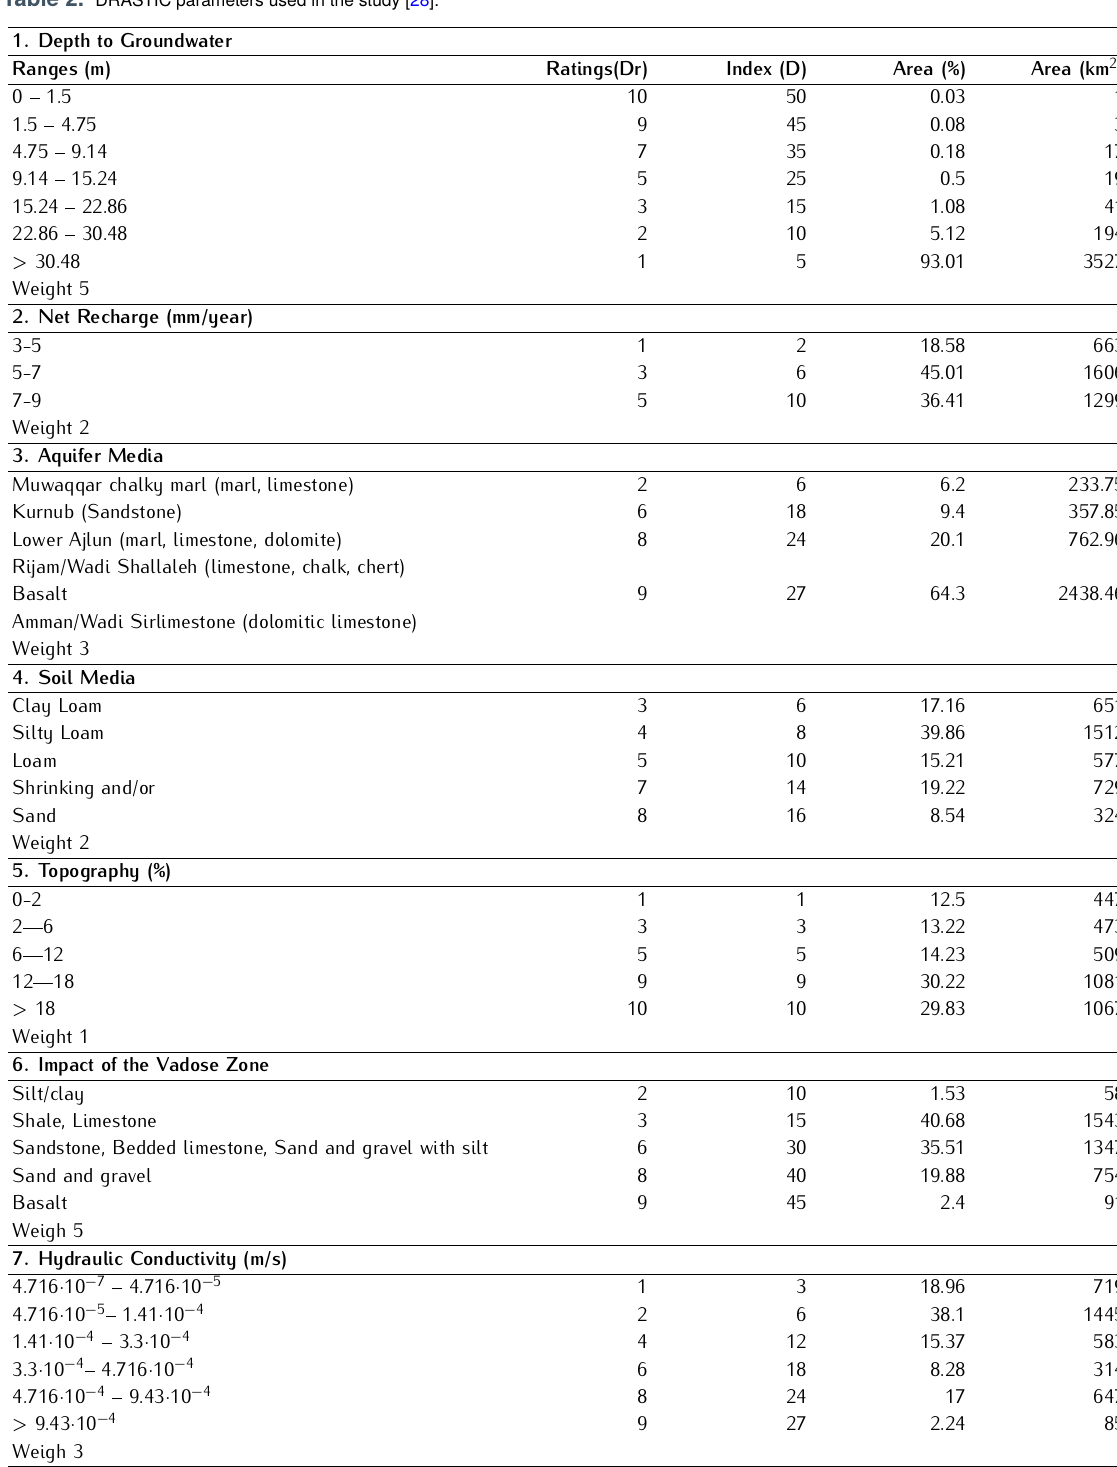
Table 2. DRASTIC parameters used in the study